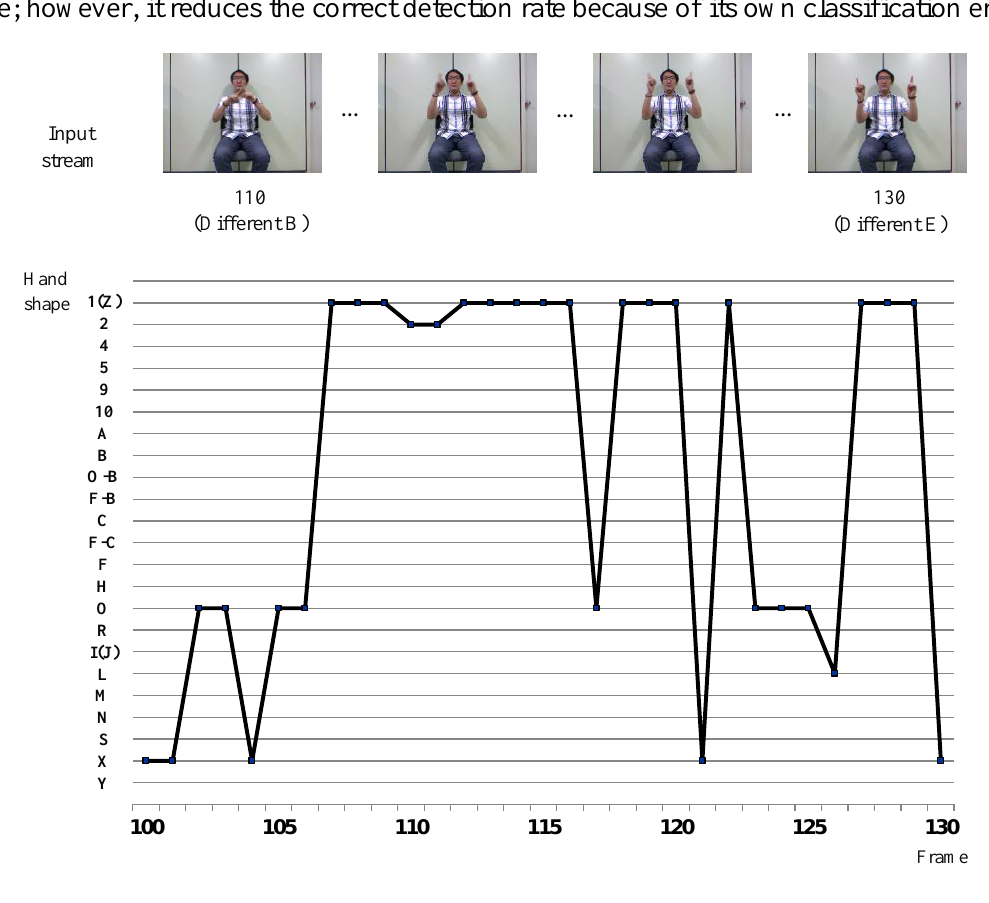
Figure 9. Hand shape recognition results with the signed sentence of Figure